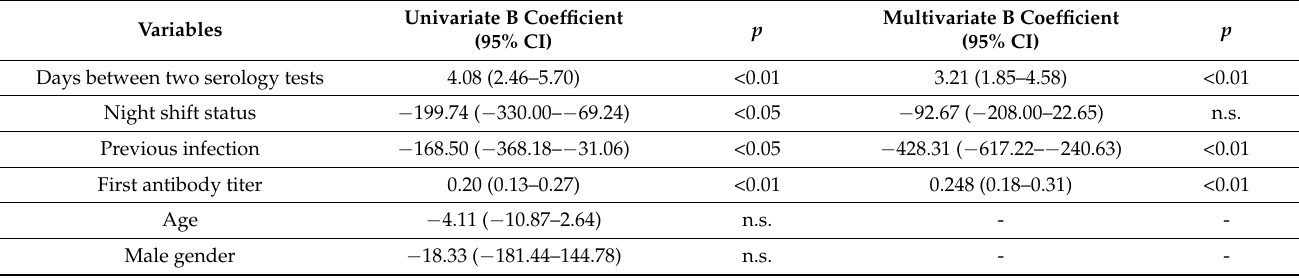
Table 2. Factors associated with the observed decrease in anti-SARS-CoV-2 antibody titers in both univariate and multivariate